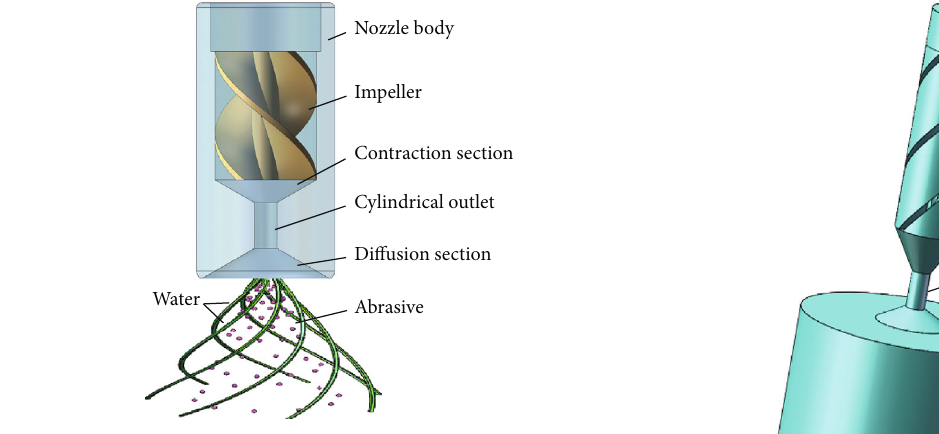
Figure 1: Structure diagram of swirling abrasive jet nozzle.